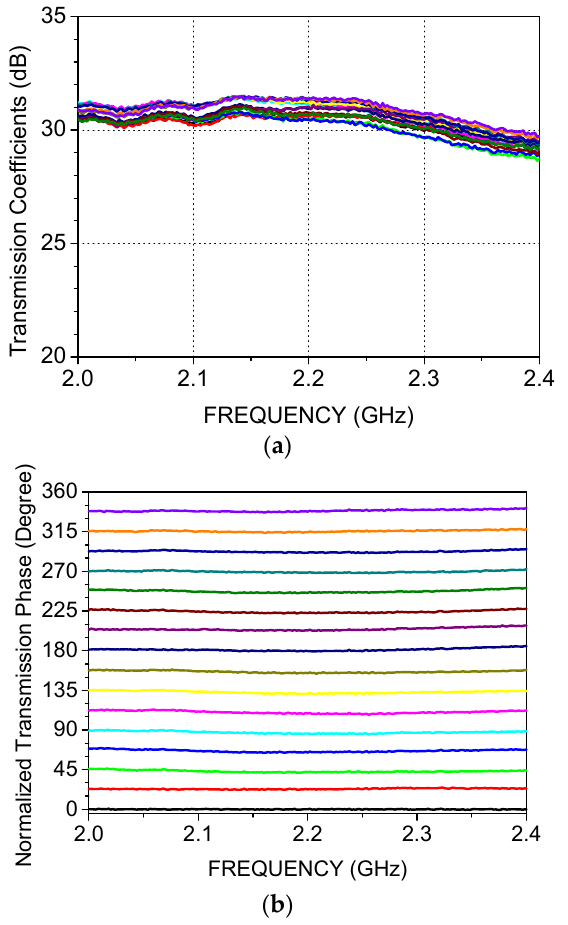
Figure 7. Performances of the beamforming Rx RF module with the 16 control states: ( a ) transmission coefficients; ( b ) transmission phases versus bit states with the 22.5 ° intervals.